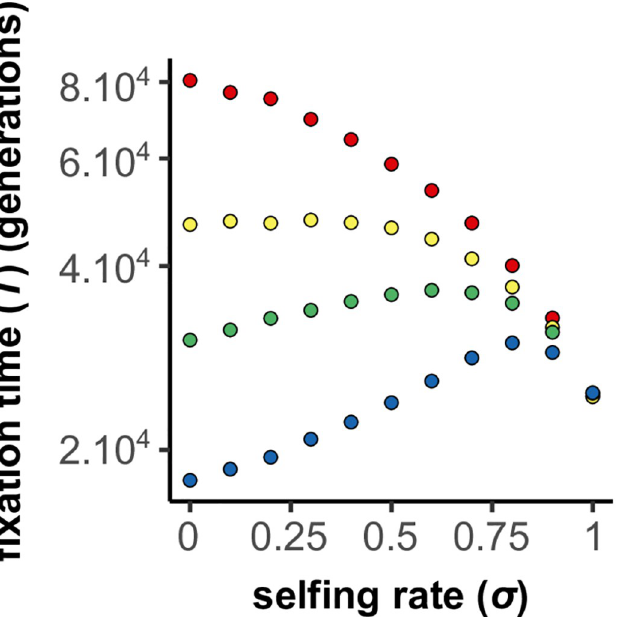
Fig 9. Effects of selfing on the fixation time of BDMi mutations when the strength of selection ( s ) varies with selfing rate ( σ ) (two-locus model). The strength of selection ( s ) decreases with selfing rate as follows: s = s 0 (1 − σ ), with s 0 = 0 (red), s 0 = 2.10 − 4 (yellow), s 0 = 4.10 − 4 (green), and s 0 = 8.10 − 4 (blue). N = 10, 000, μ = 2.5.10 − 5 , h = 0.5, h k B = 0.5, s B = 10 − 3 , r = 0.5. 10, 000